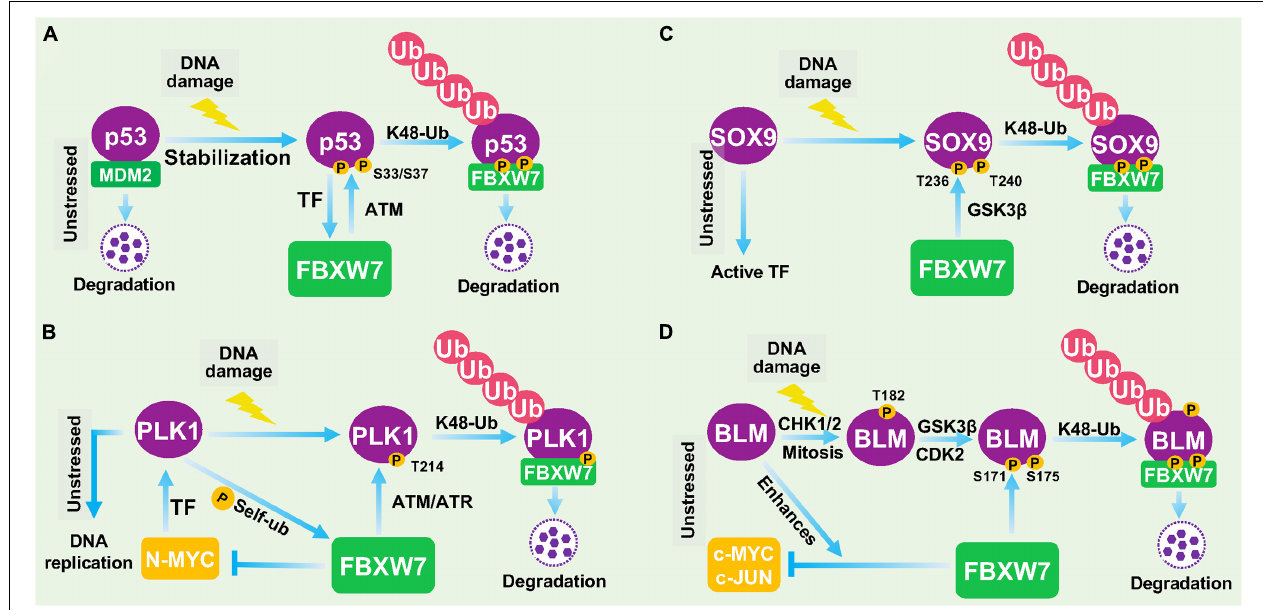
FIGURE 3 | FBXW7 in DNA damage responses. (A) Negative feedback loop between FBXW7 and p53. Under unstressed condition, p53 level is low due to targeted degradation by MDM2 E3 ligase. Upon DNA damage, p53 protein is accumulated to transcriptionally induce FBXW7 expression; the induced FBXW7 then promotes p53 ubiquitylation and degradation after ATM-mediated p53 phosphorylation at Ser 33 / 37 residues (Cui et al., 2020). (B) PLK1 degradation by FBXW7 upon DDR. Under unstressed condition, PLK1 was transcriptionally induced by N-MYC. PLK also phosphorylates FBXW7 to trigger its self-ubiquitylation and cause N-MYC accumulation. Upon DNA damage, ATM/ATR phosphorylates PLK1 at Thr 214 , which facilitated FBXW7 binding and subsequent ubiquitylation and degradation. (C) FBXW7 degrades SOX9 upon DDR. Under unstressed condition, SOX9 acts as a transcription factor. Upon DNA damage, SOX9 was phosphorylated at Thr 236 / 240 by GSK3 β , which facilitated FBXW7 binding and subsequent ubiquitylation and degradation. (D) FBXW7 degrades BLM upon DDR. Upon DNA damage, BLM was sequentially phosphorylated at Thr 182 by CHK1/2, and at Thr 171 and Ser 175 by GSK3 β /CDK2, which facilitated FBXW7 binding and subsequent ubiquitylation and degradation. TF, Transcription